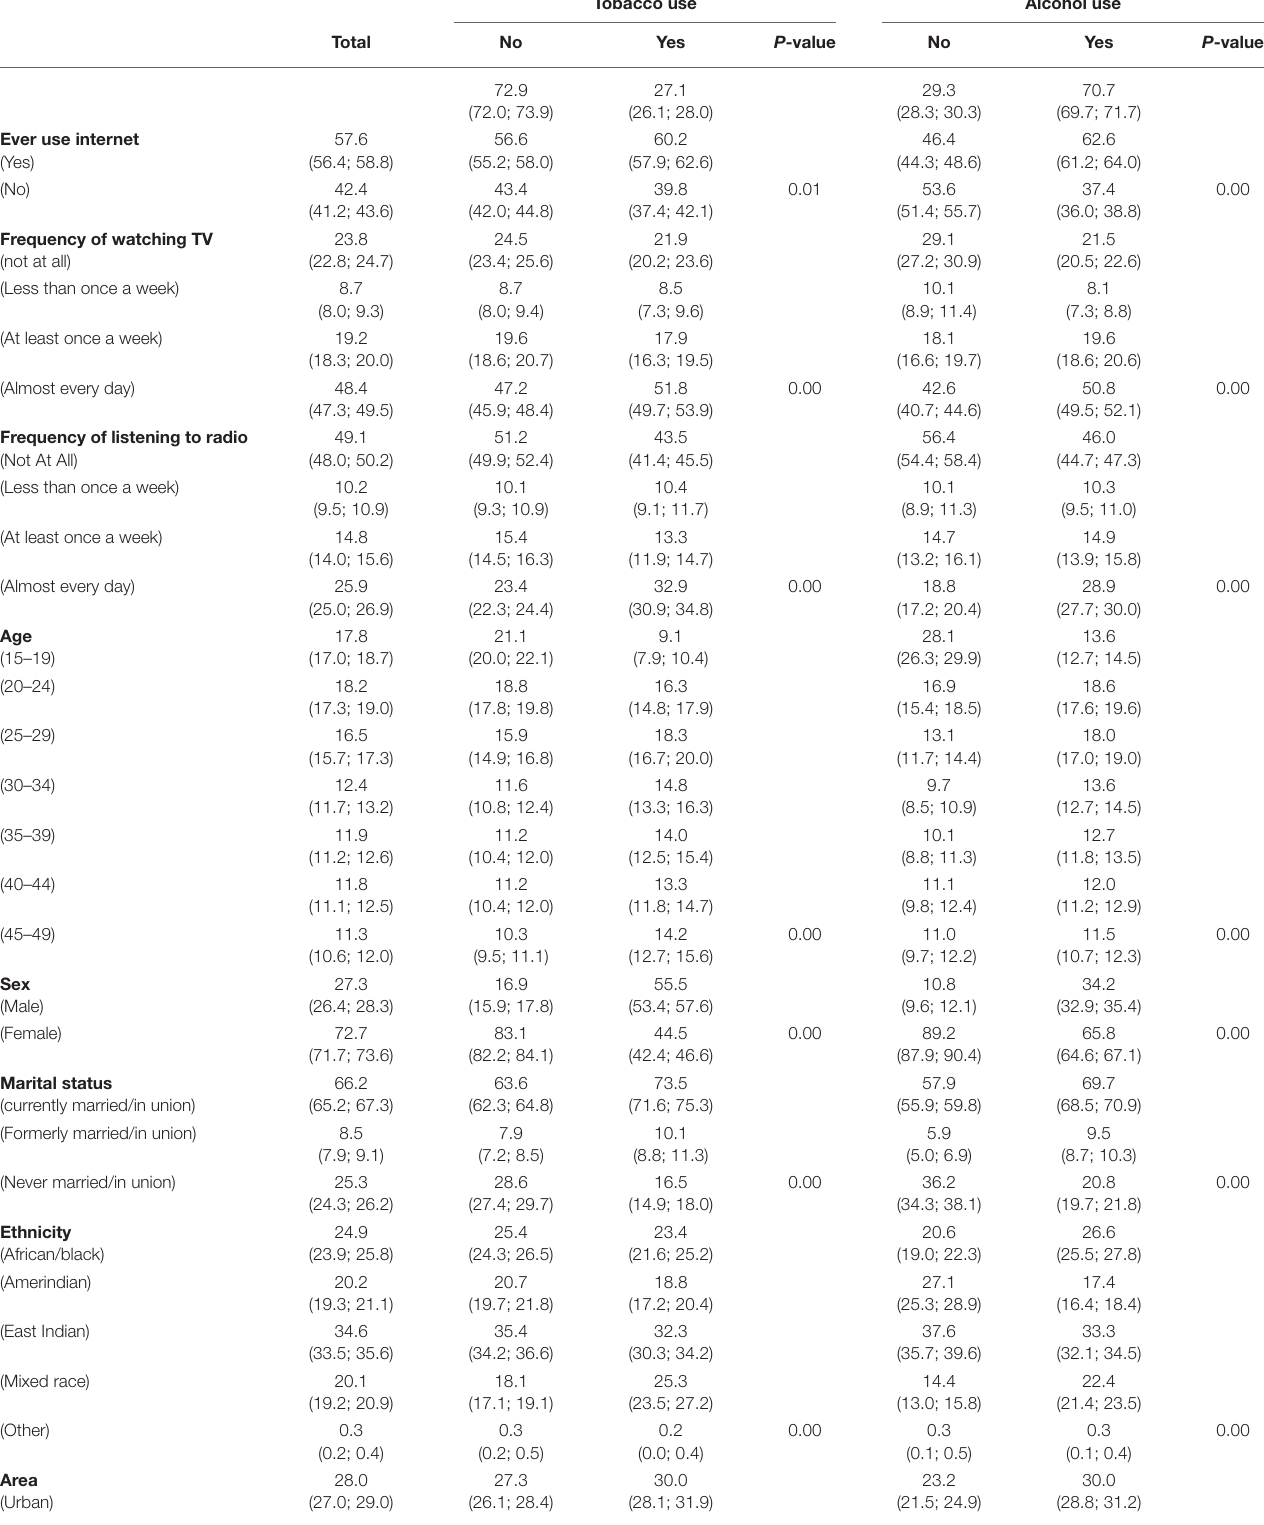
TABLE 1 | Percentage of sample population reporting ever using tobacco and